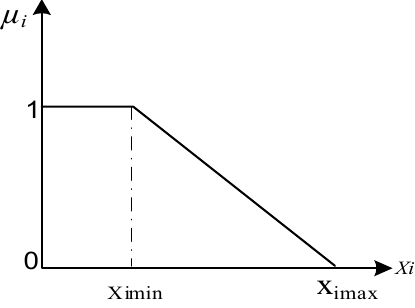
Figure 1. Values of μ for each objective function.